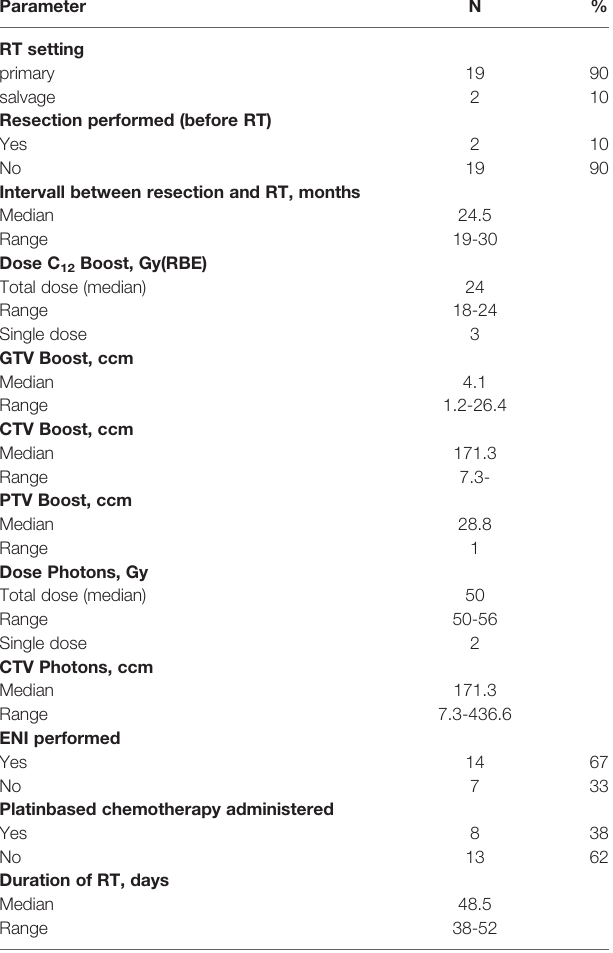
TABLE 3 | Treatment